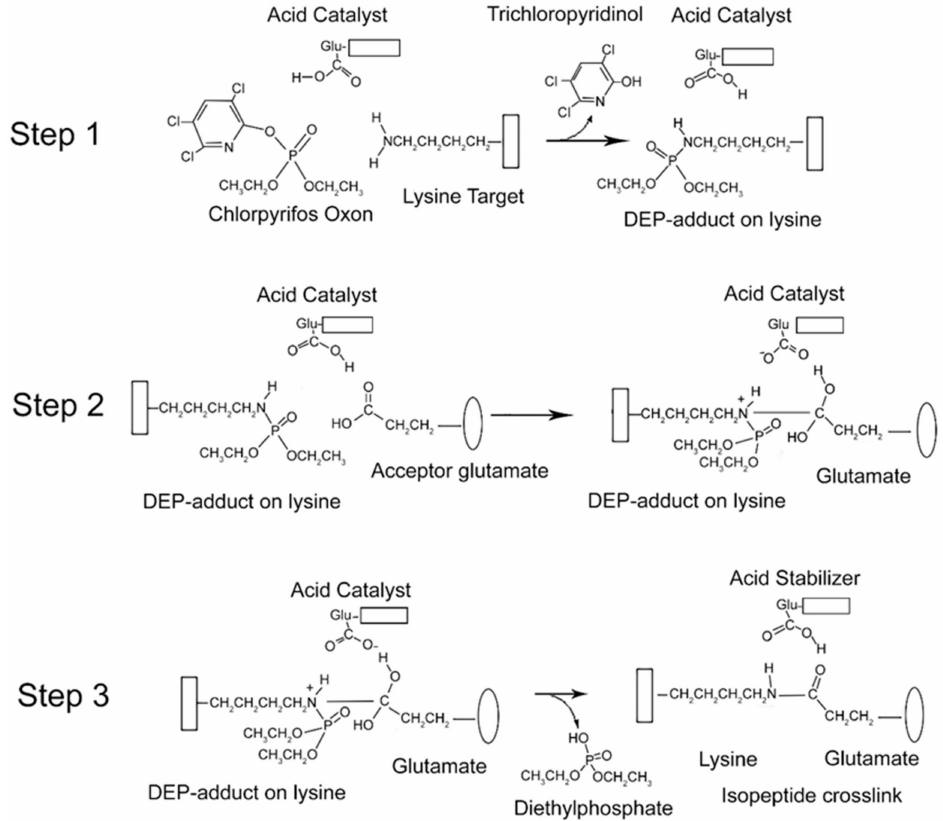
Figure 6. Mechanism for CPO-promoted isopeptide bond formation between lysine and glutamate. Step 1: diethylphosphate (DEP)-adduct formation on lysine catalyzed by a nearby glutamate.